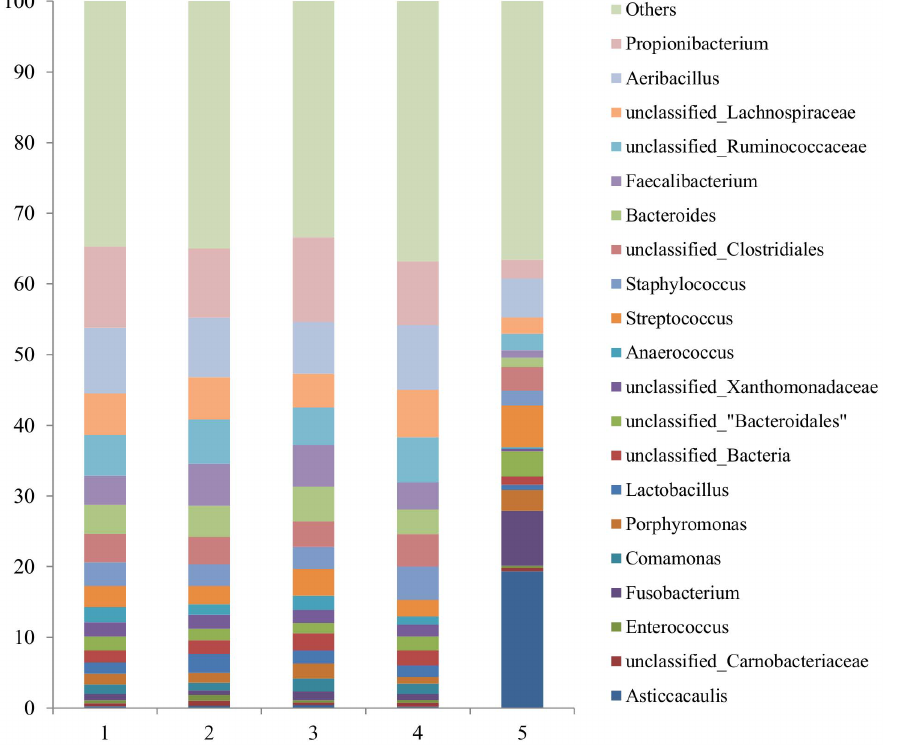
Figure 1. Average prevalence of the twenty most prevalent bacterial genera for each different group of samples (1=healthy quarter, somatic cell count , 20.000; 2=healthy quarter, somatic cell count ranged from 21,000 to 50,000; 3=healthy quarter, somatic cell count . 50,000; 4=subclinical culture positive quarters, somatic cell count . 400,000; 5=mastitis quarter culture negative